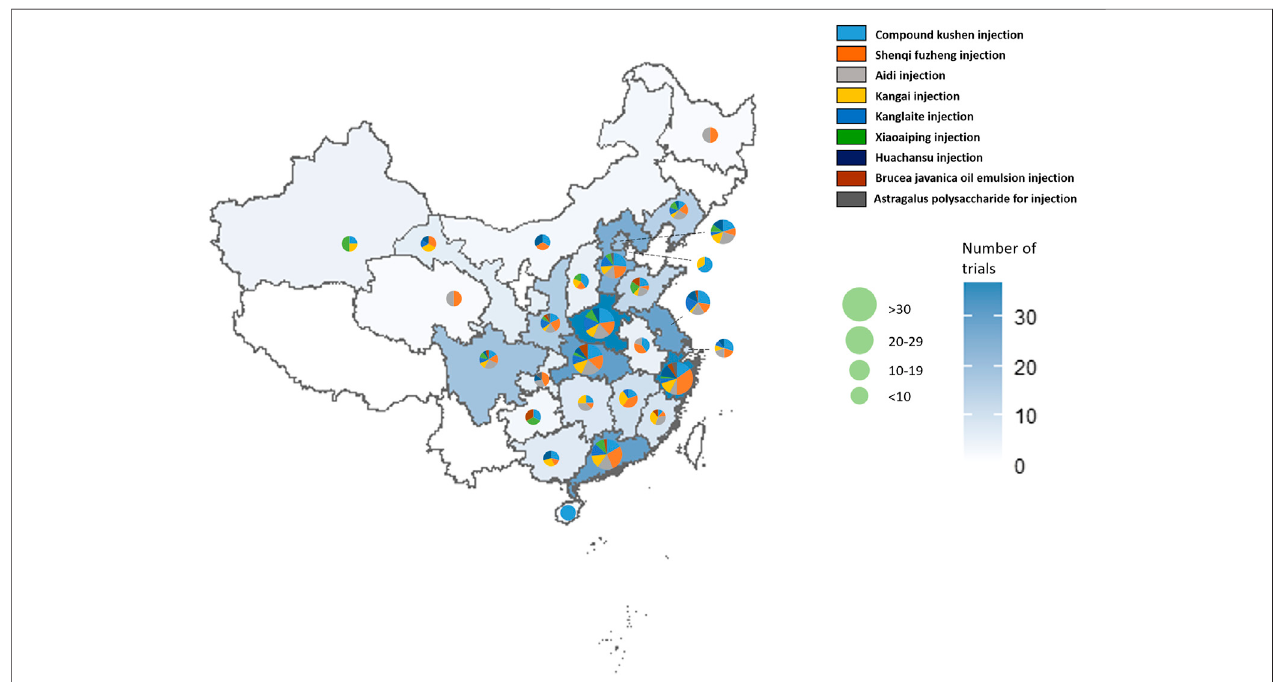
FIGURE 2 | The geographical distribution of the primary investigators of RCTs on herbal injections for cancer care.